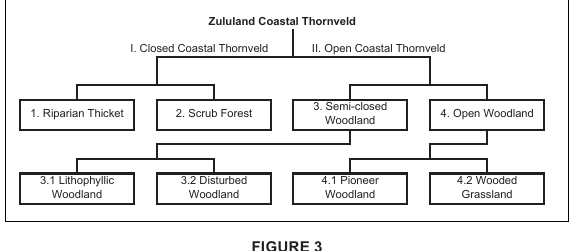
Figure 3 Dendrogram based on TWINSPAN divisions depicting the floristic relationships between the different woody assemblages of Zululand coastal thornveld